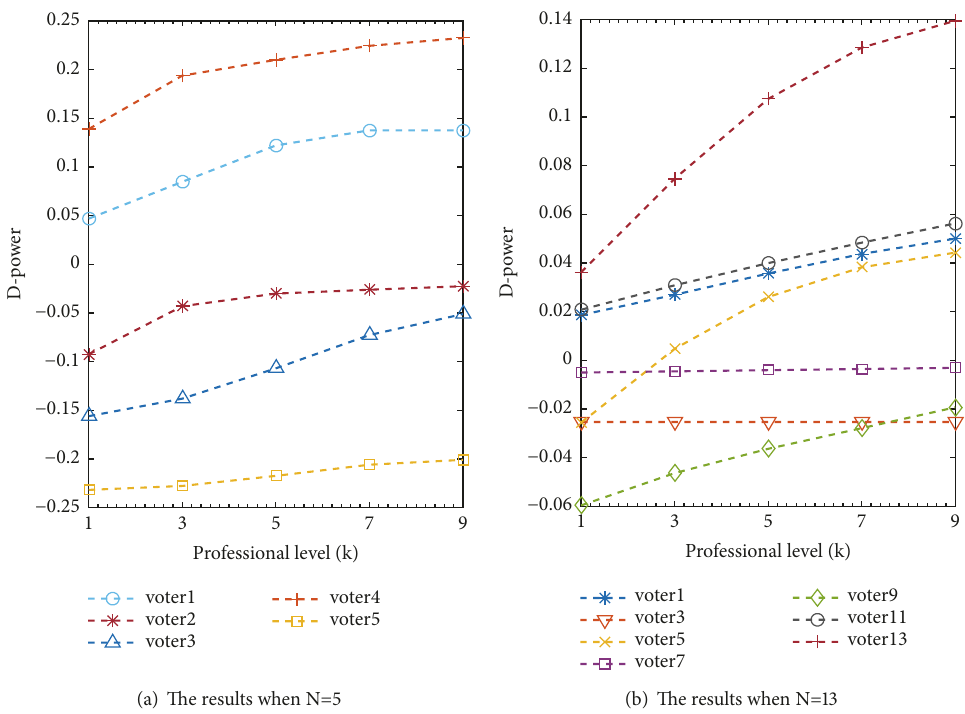
Figure 7: Robustness of professionalism influence. Subgraph (a) shows the simulation results of 5 players (i.e., 𝑁 = 5 ) who play a repeated voting game in a social network with a 30% random connection probability, accompanied by voter 𝑖 ’s professional level 𝑘 𝑖 rising from 𝑘 𝑖 = 1 to 𝑘 𝑖 = 9 , while leaving other parameters unchanged. Subgraph (b) shows the results of 13 players (i.e., 𝑁 = 13 ) with the same simulation conditions. The changes in power indices ( 𝐷 - 𝑝𝑜𝑤𝑒𝑟(𝑖) = 𝑅 󸀠 (𝑖) − 𝐵 󸀠 (𝑖) ) improve with the professional level increasing in both cases, except for the isolated